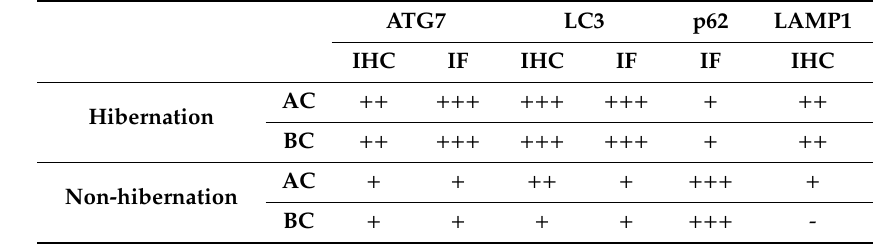
Figure 4. ( A ) Fluorescence intensity quantification of ATG7, LC3, and p62 (n = 10 turtle / group and 20 villi / section of each turtle). The values represent mean ± SEM. * indicates a statically significant difference between hibernation and nonhibernation. ( B ) Immunoblotting protein expression levels of LC3, p62, PINK1, and AMPK in the small intestine of P. sinensis during hibernation and nonhibernation. Experiments were repeated three times, with similar results in each. Table 2. Distribution of ATG7, LC3, p62, and LAMP1 in the mucosal region of the small intestine during hibernation and nonhibernation.